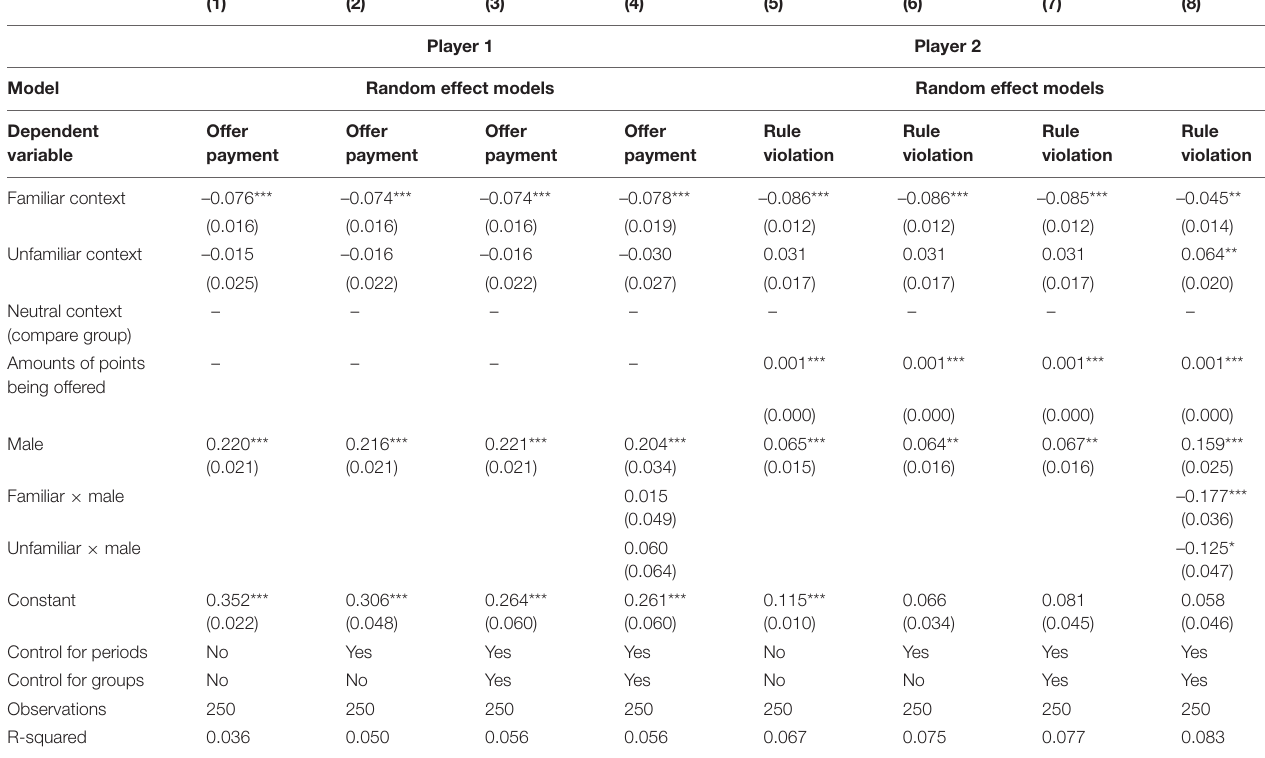
Table 9 | Regression analysis with random effect